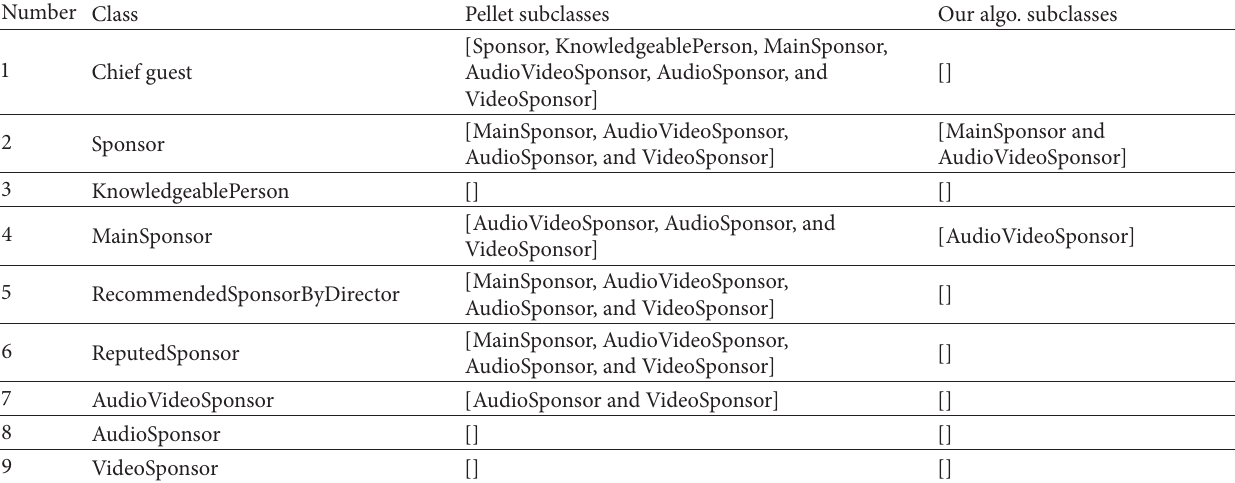
Table 7: Conference cases subclass calculation results: